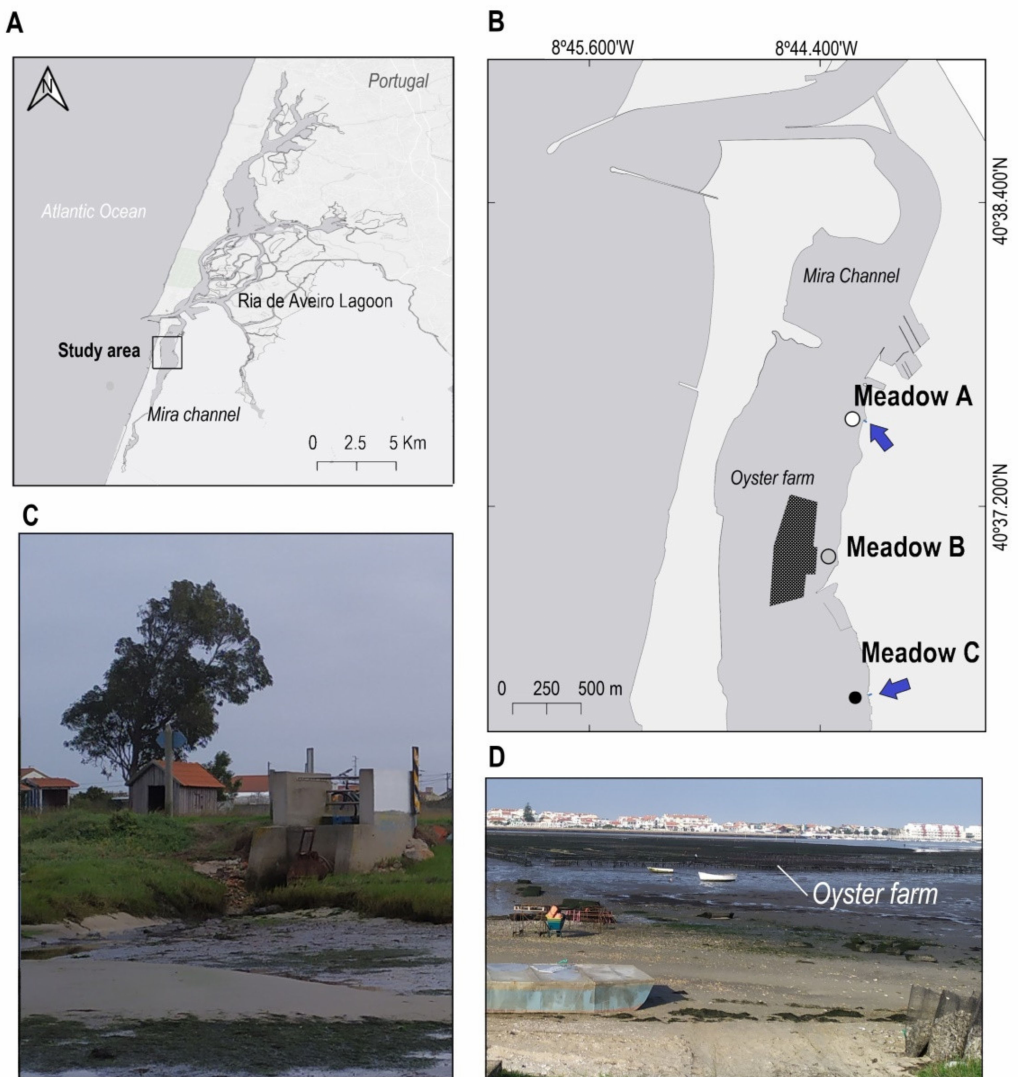
Figure 1. Study area (Ria de Aveiro, Center of Portugal) ( A ) and location of the three Z. noltei meadows in the Mira Channel ( B ). The dark area in ( B ) indicates the location of the oyster farming, while the blue arrows indicate the position of the storm drain outlets. The white, grey and black spots of ( B ) show the location of each Z. noltei meadow. ( C ) shows the storm drain outlet and runoff of the Meadow C. ( D ) displays the oyster farm trestles and farming activities in Meadow